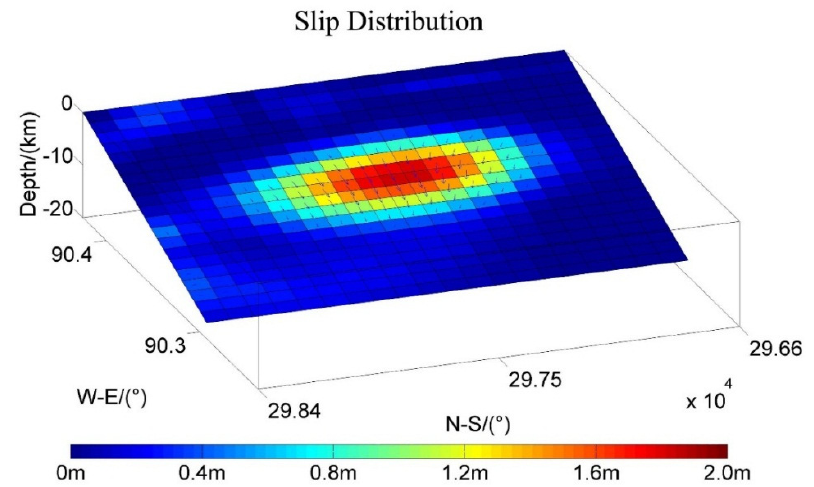
Figure A1. Slip distributions estimated from the HET model with the DInSAR observations. Color scale shows slip movement in m.